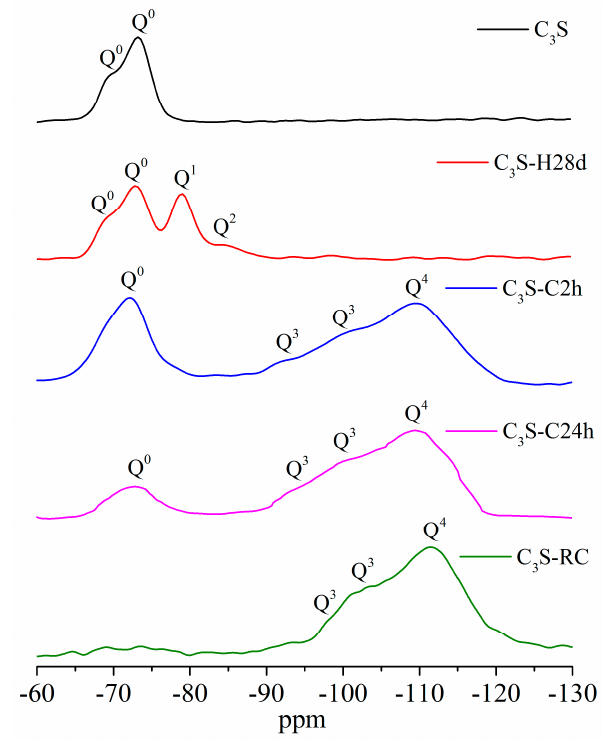
Figure 15. 29 Si magic angle spinning–nuclear magnetic resonance (MAS-NMR) pattern of different samples.